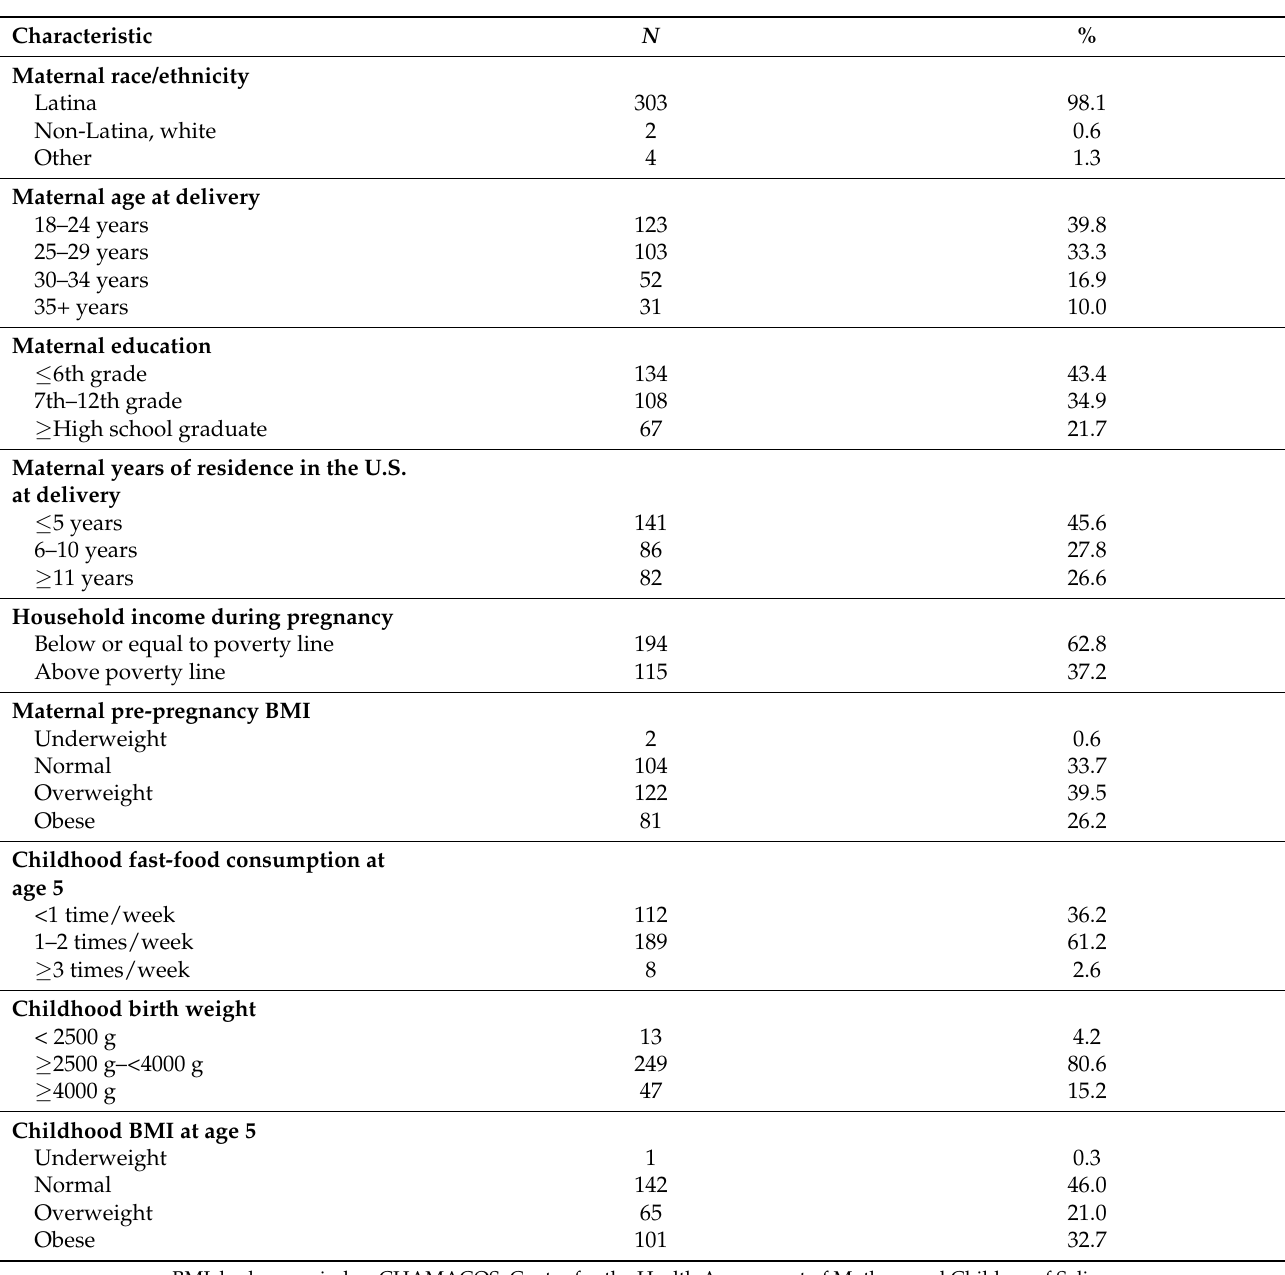
Table 1. Demographic characteristics of the CHAMACOS population ( N =